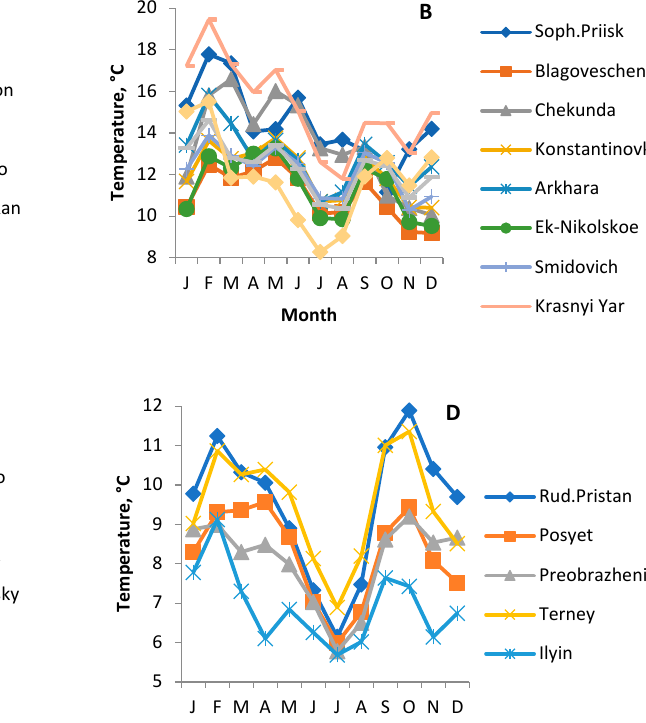
(10.2 ◦ C) and in October for Vladivostok (7.1 ◦ C). These patterns can be explained by